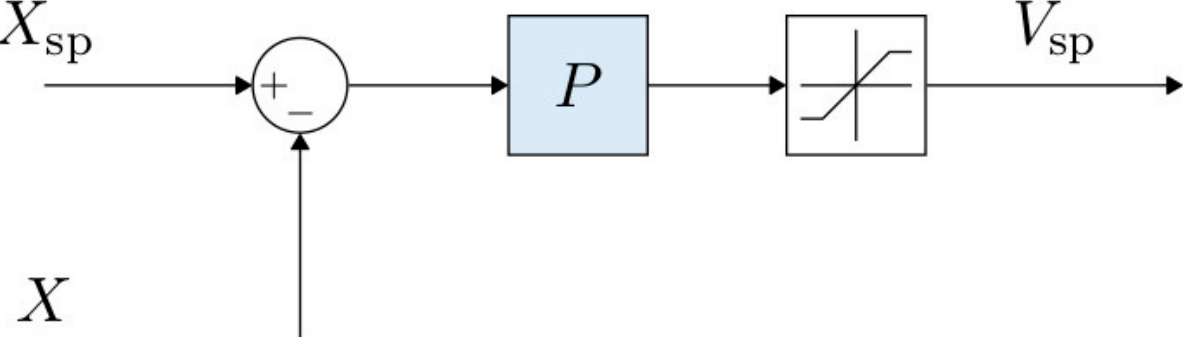
Figure 10. PX4 controller algorithm for position control (source: [51]).